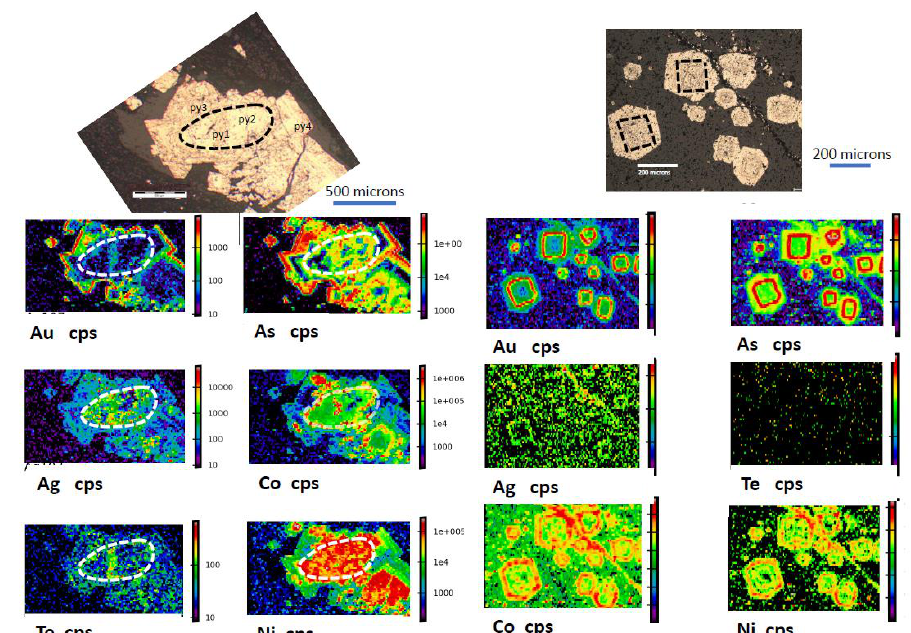
Figure 7. ( A ) LA-ICPMS maps of pyrite aggregate from disseminated pyrite halo, Bendigo quartz reefs [27]. Note the Ni-rich nodular core (py1 and py2) and the Au-As-rich rim (see also Figure 2). ( B ) LA-ICPMS maps of pyrite euhedra from the Mt Olympus deposit. Au and As enrichment (red) is present as an internal band, surrounded by a Co-Ni-bearing rim.